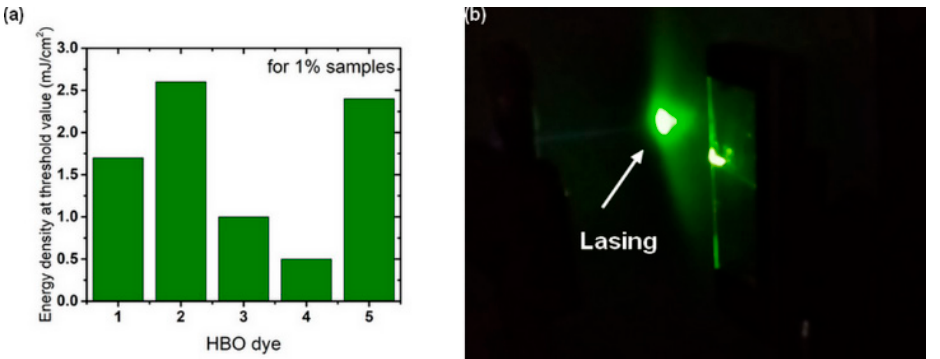
Figure 9. ( a ) Difference between random lasing threshold values for 1% samples of HBO dyes 1 – 5 in PMMA matrix and ( b ) a photography of the stimulated emission above the RL threshold observed for 1% doped HBO 5 in the PMMA sample.